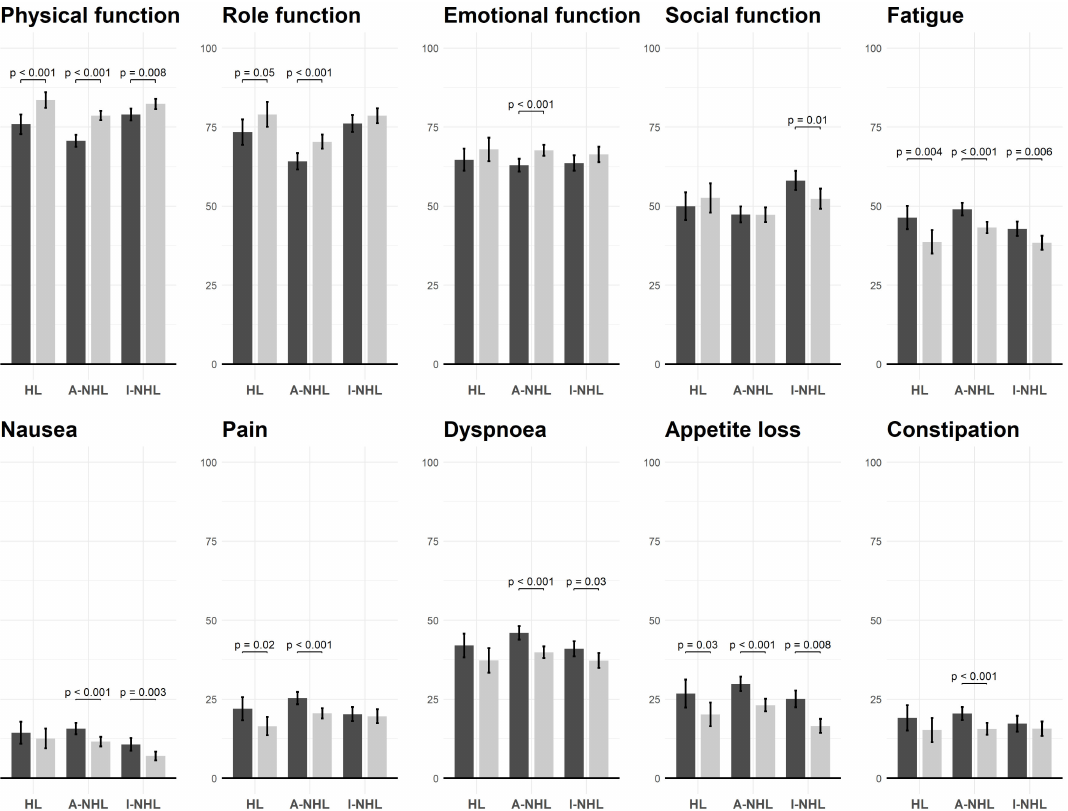
Figure 1. Significant difference of QLQ-C30 items, stratified by response type and lymphoma types. Dark and light grey indicates proxy-reported and self-reported patients, respectively; HL: Hodgkin’s lymphoma, A-NHL: Aggressive Non-Hodgkin’s lymphoma, I-NHL: Indolent Non-Hodgkin’s lymphoma. Multiple linear regression analysis indicated that proxies reported a higher physical (co- and social HRQoL (b = − 5.09, [95% CI − 8.62, − 1.55]), than patients when adjusted for